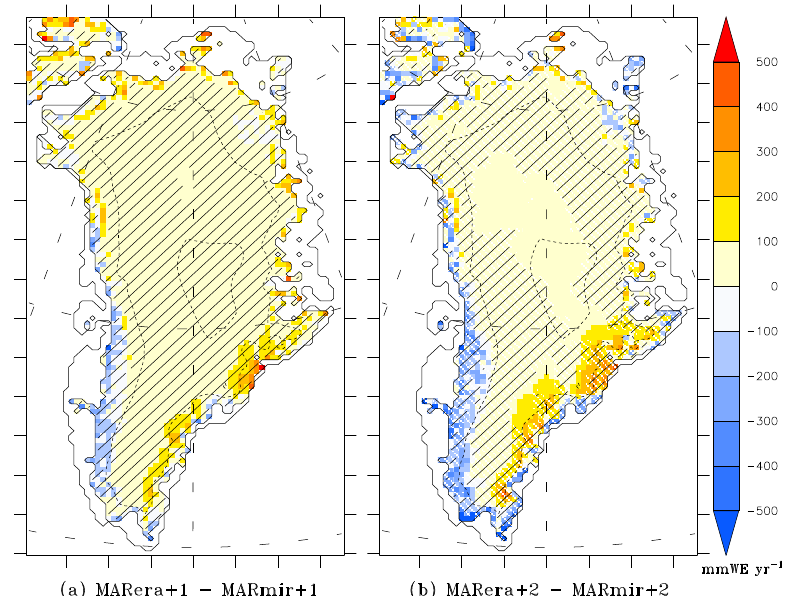
Figure 1. Differences of mean anomalies of annual SMB (in mmw.e.y − 1 ) between (a) MARera+1 and MARmir+1 and (b) MARera+2 and MARmir+2. Areas where anomaly differences are smaller than the inter-annual variability (i.e. the standard deviation) of the simulation of MAR forced by unaltered ERA-Interim over 1980–1999 are hatched. Dashed lines are equal altitude lines of 2000 and 3000m. See Appendix A and Tables A1 and A2 for